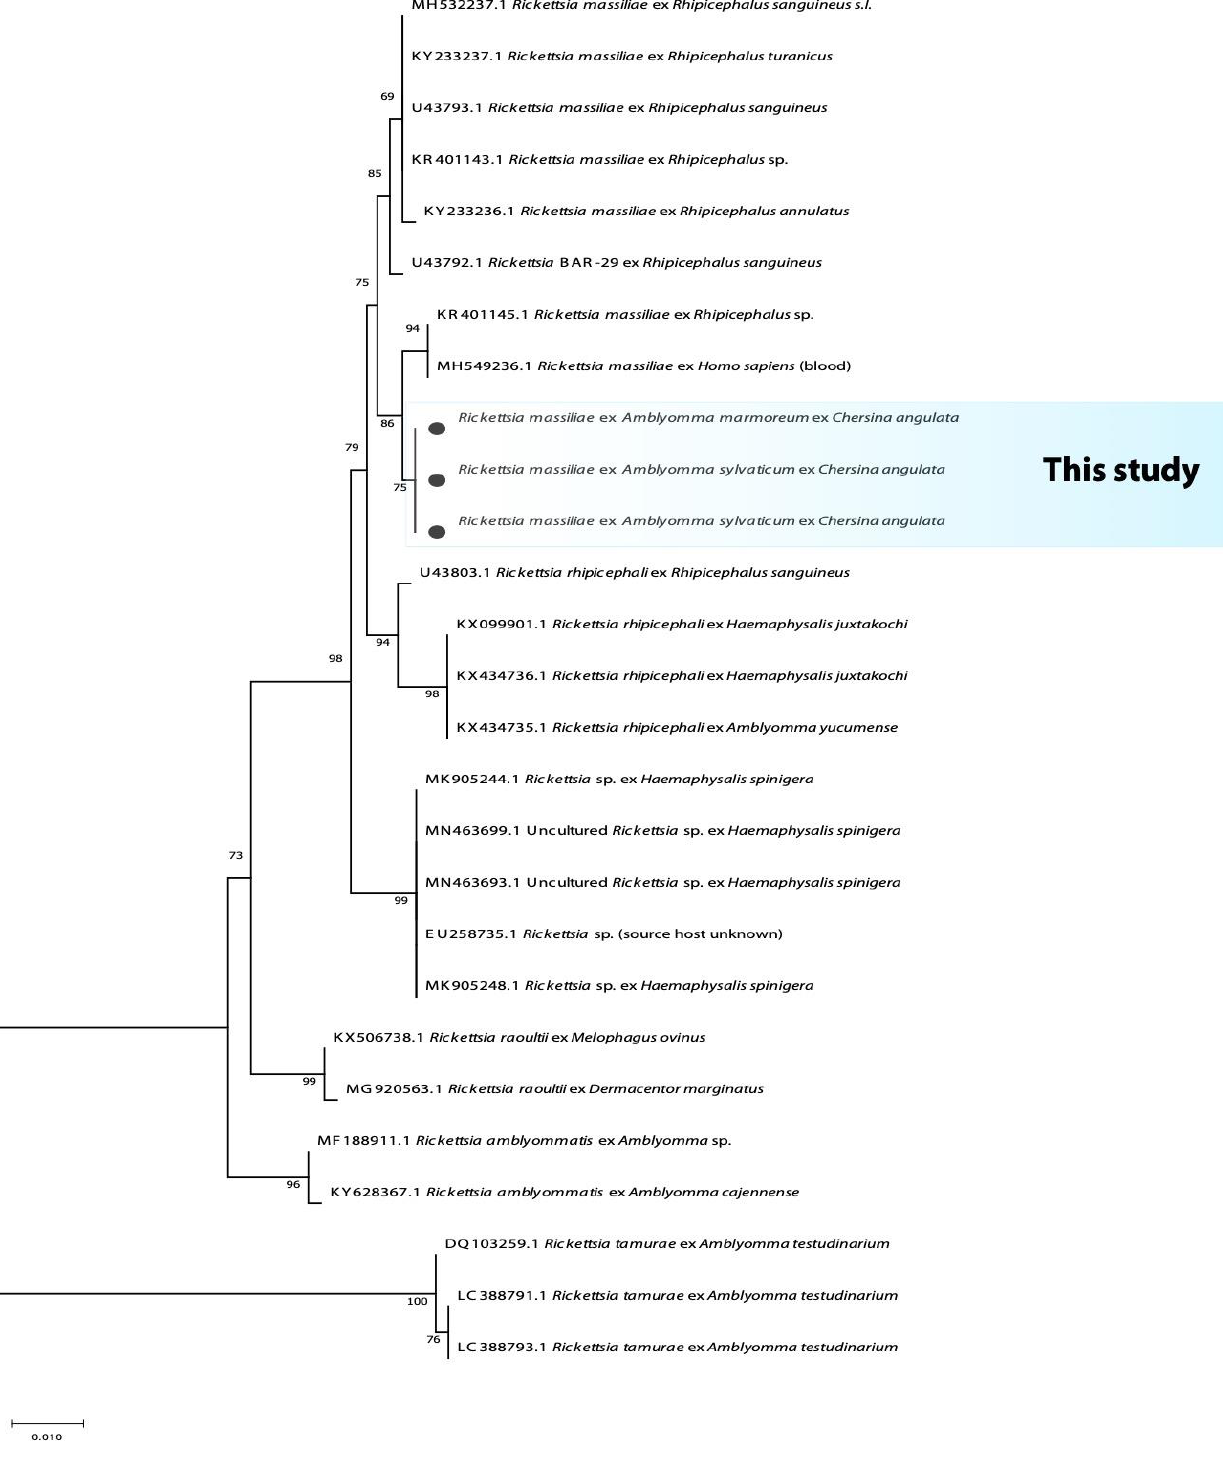
Figure 3. Phylogenetic tree based on the sequences of the Rickettsia OmpA gene. The tree was constructed using MEGA 11 based on the maximum likelihood, using the Tamura 3-parameter model. The sequences obtained in this study are indicated with bullets.